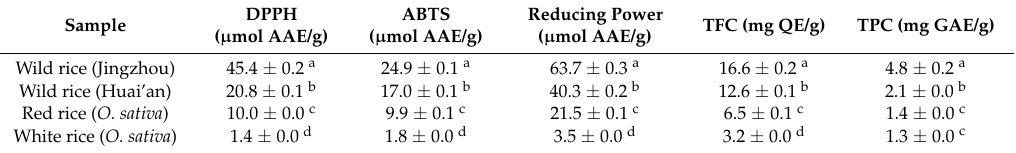
Table 1. Antioxidant activities, total flavonoid content (TFC), and total phenolic content (TPC) of ethanol crude extracts from wild rice and control